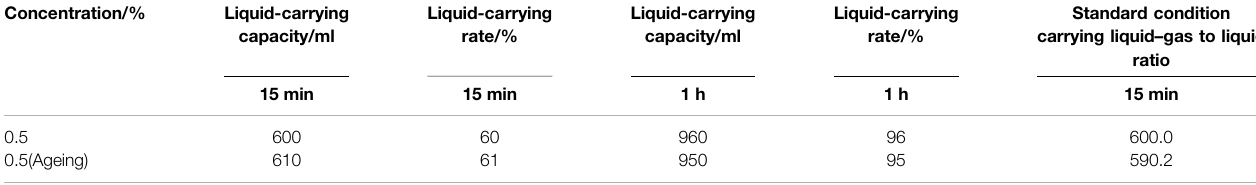
TABLE 3 | Comparison of liquid-carrying capacity of ZHY-01 aged at room temperature and high temperature at 0.5% concentration.